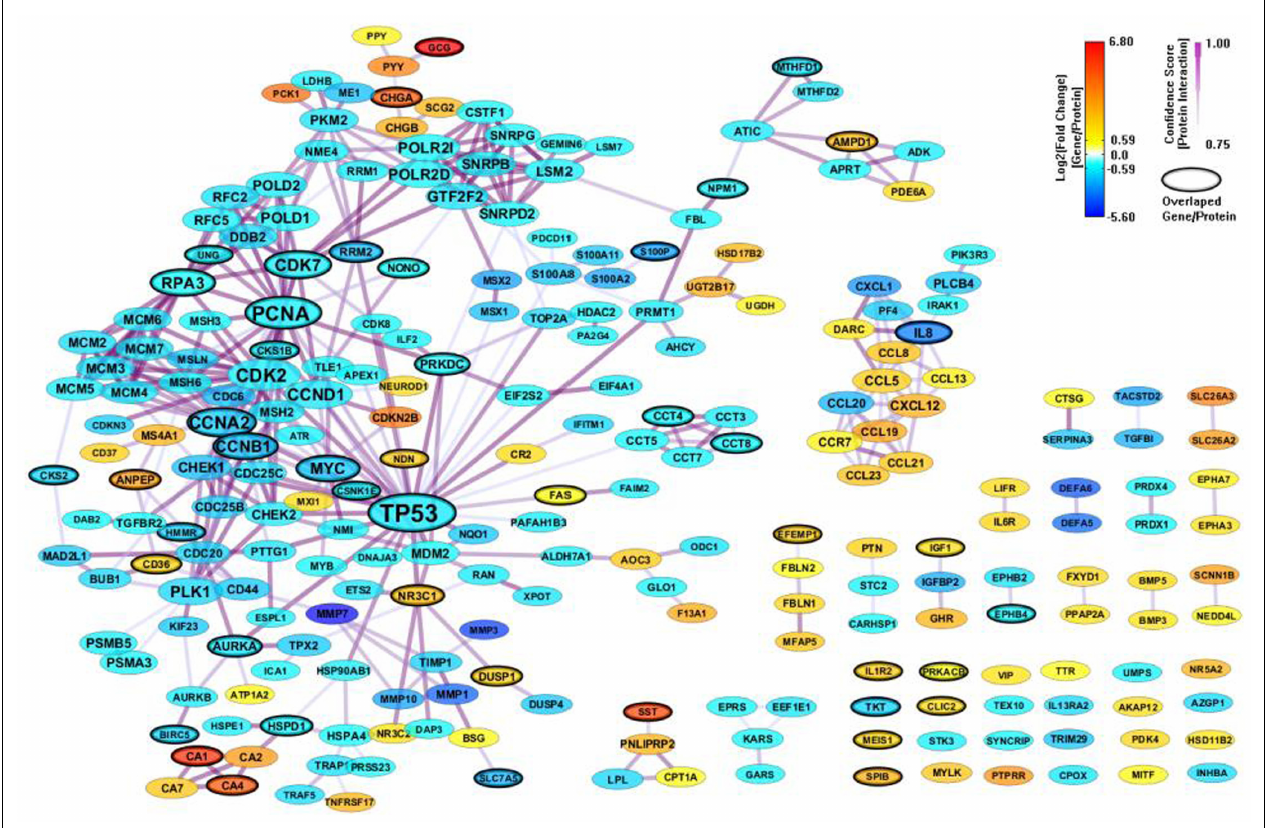
represent differential gene expressions, node size represents the local topological property, edge color, and edge width represents confidence score for each protein interaction. Black-circled genes represent the enriched genes from both MSigDB and